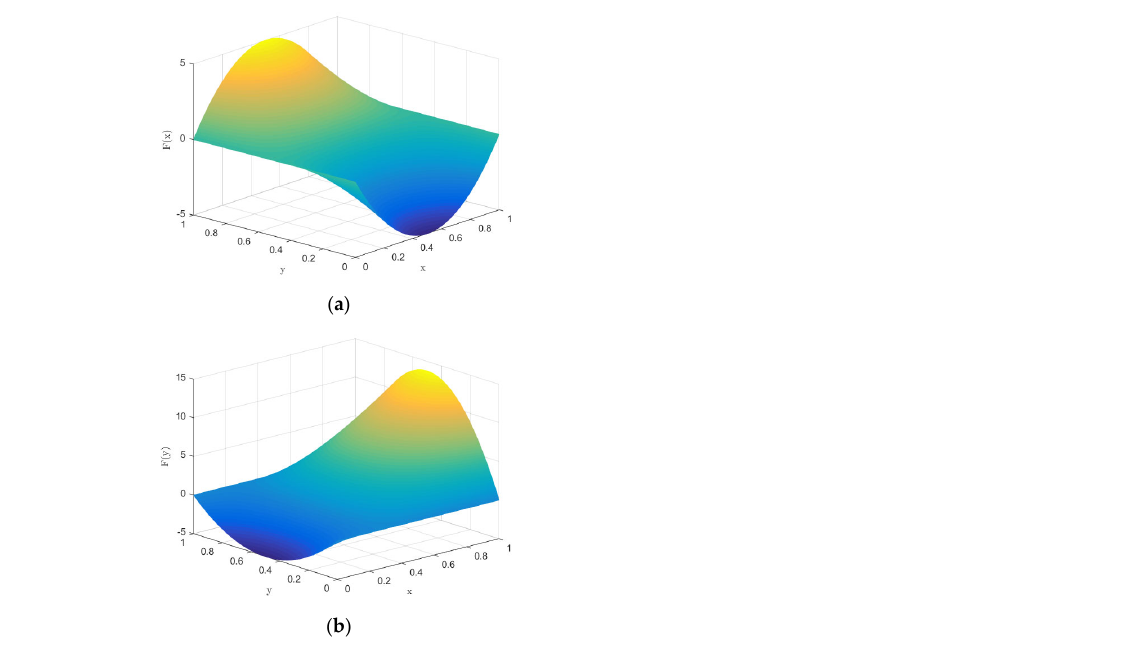
Figure 2. Numerical evolution diagram of pharmaceutical enterprises ( a ) and 3PL enterprises ( b ).